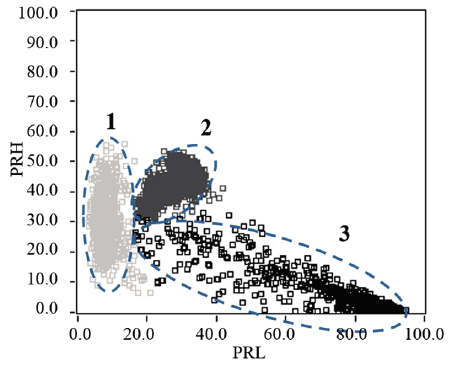
Figure 10. PR map obtained for noise (cluster 1), corona PD (cluster 2) and internal PD (cluster